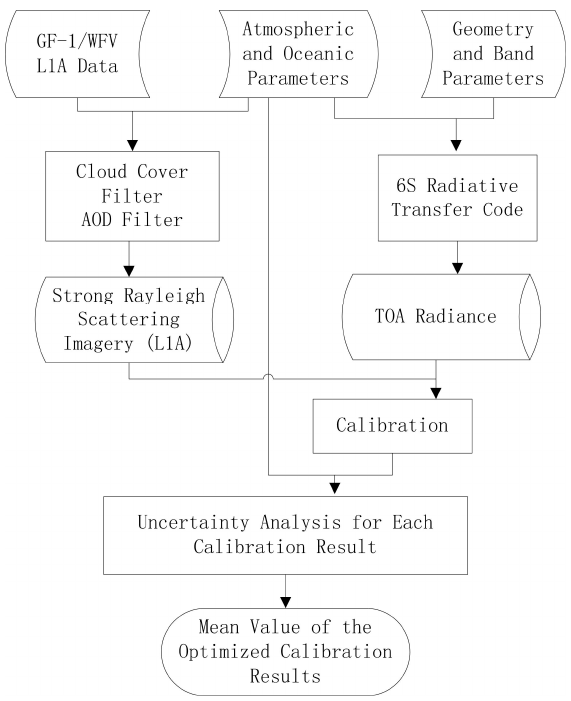
Figure 2. The flow chart of the Rayleigh scattering calibration for the Wide Field Viewing cameras onboard Gaofen-1 satellite (GF-1/WFV).